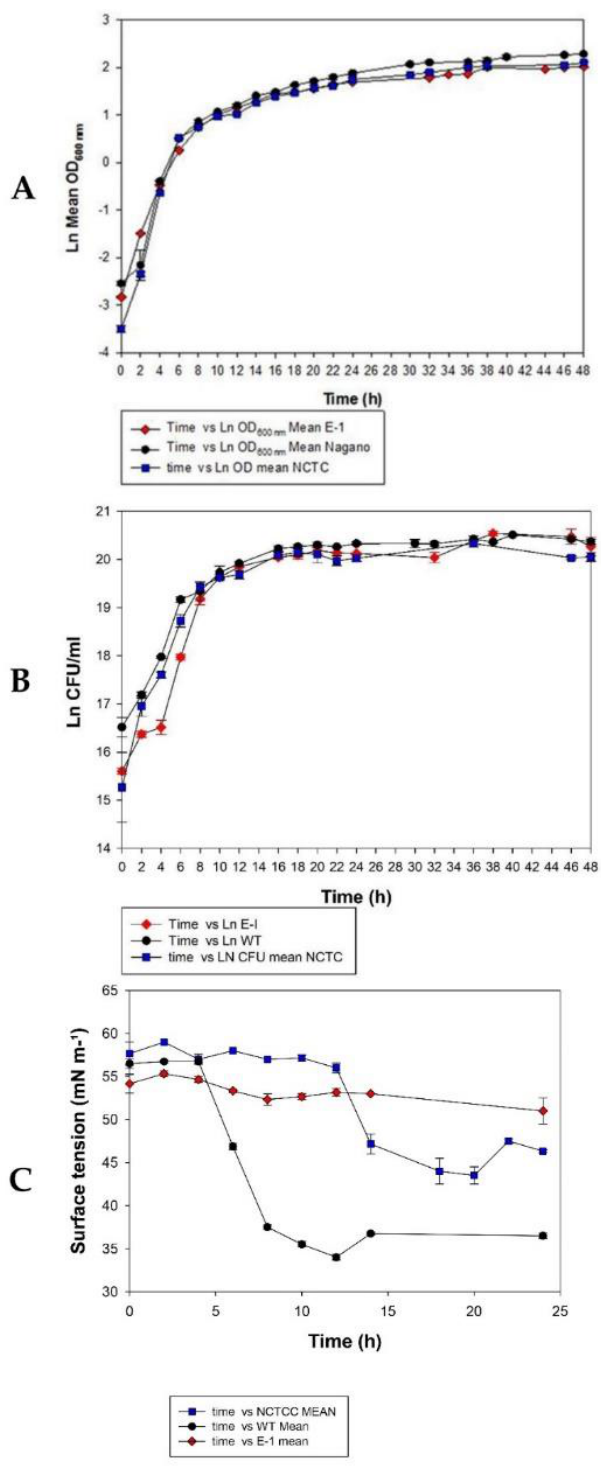
Figure 1. The comparison of growth rates among the three strains of A. migulanus. ( A ) Optical density (OD 600nm ) measurements for (●) A. migulanus Nagano, ( ■ ) NCTC 7096, and ( ♦ ) E1. ( B ) Colony forming units (CFU) per mL for ( • ) A. migulanus Nagano, ( (cid:4) ) NCTC 7096, and ( (cid:7) ) E1. Vertical bars represent standard errors of the means of three independent replicates. ( C ) Aneurinibacillus migulanus biosurfactant effects on surface tension of culture fluids and time course of changes in surface tension of ( • ) A. migulanus Nagano, ( (cid:4) ) NCTC 7096, and ( (cid:7) ) E1 in culture fluids. Vertical bars represent standard errors of the means (N =